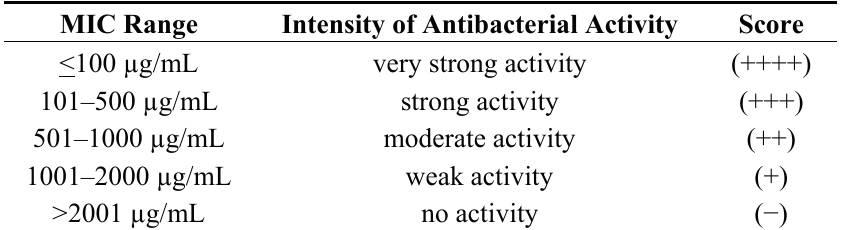
Table 11. Established parameters based on Minimum Inhibitory Concentrations of essential oils or related chemical